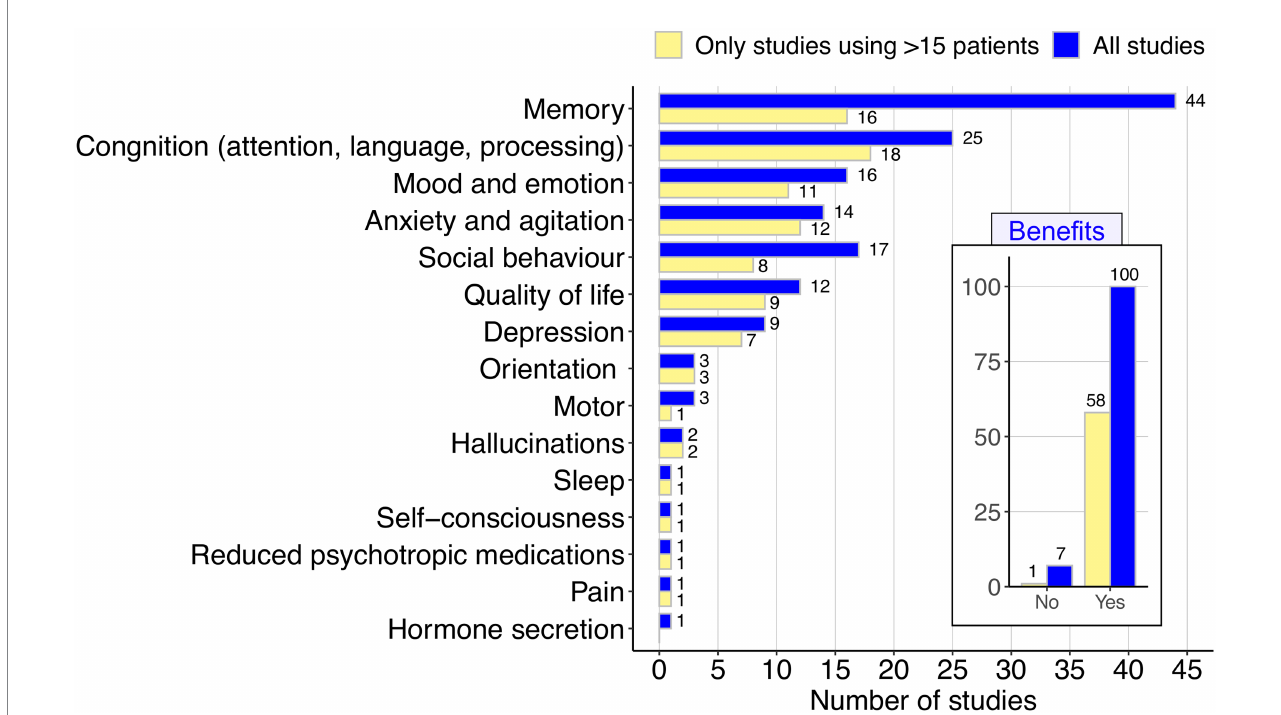
FIGURE 2 Summary of the beneficial effects of music in AD as reported in a total of 107 articles (see Figure 1). The inset figure indicates the number of articles that report some benefit vs. those with negative findings for the benefits; while the main figure describes with more detail the different benefits reported. The graphic was carried out considering the total amount of articles (blue), and only those based on the analysis of a minimum of patients